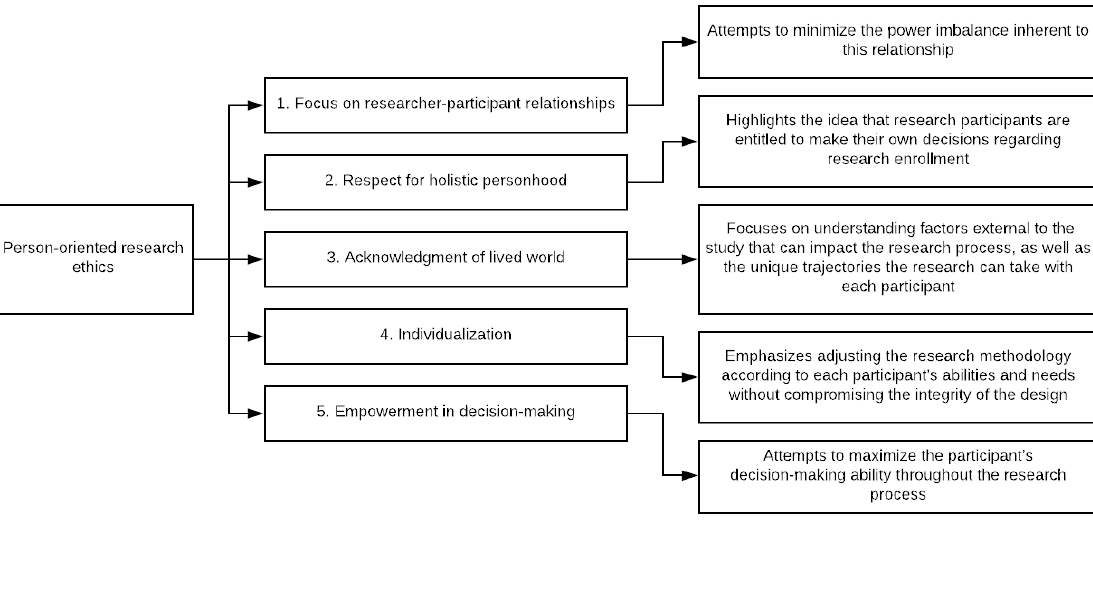
Figure 1 : Five guideposts of person-oriented research ethics (adapted from Cascio and Racine